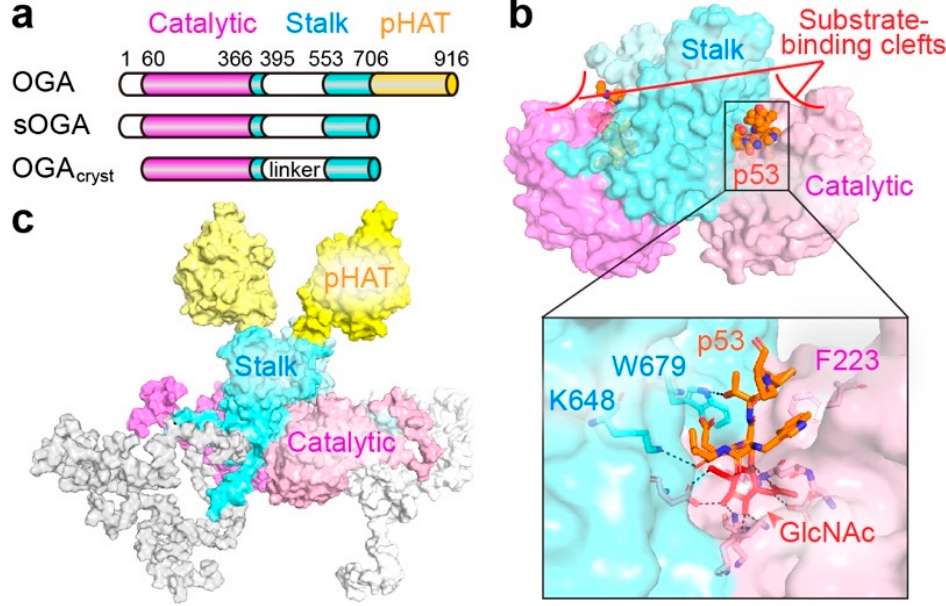
Figure 3. OGA structures provide clues to substrate recognition and protein interactions. ( a ) Schematic diagram of two OGA isoforms (OGA and sOGA) and OGA cryst , a reported crystallizable OGA construct. The catalytic domain, stalk domain, and pseudo histone acetyltransferase (pHAT) domain are shown in magenta, cyan, and yellow, respectively. Intrinsically disordered regions of OGA are shown in white. ( b ) The crystal structure of O-GlcNAcylated p53 peptide (highlighted in orange) bound in the substrate-binding clefts of OGA cryst dimer (PDB: 5UN8). Insert highlighted the p53 peptide interactions with OGA residues. ( c ) Predicted full-length OGA model with its domains colored as in ( a ).